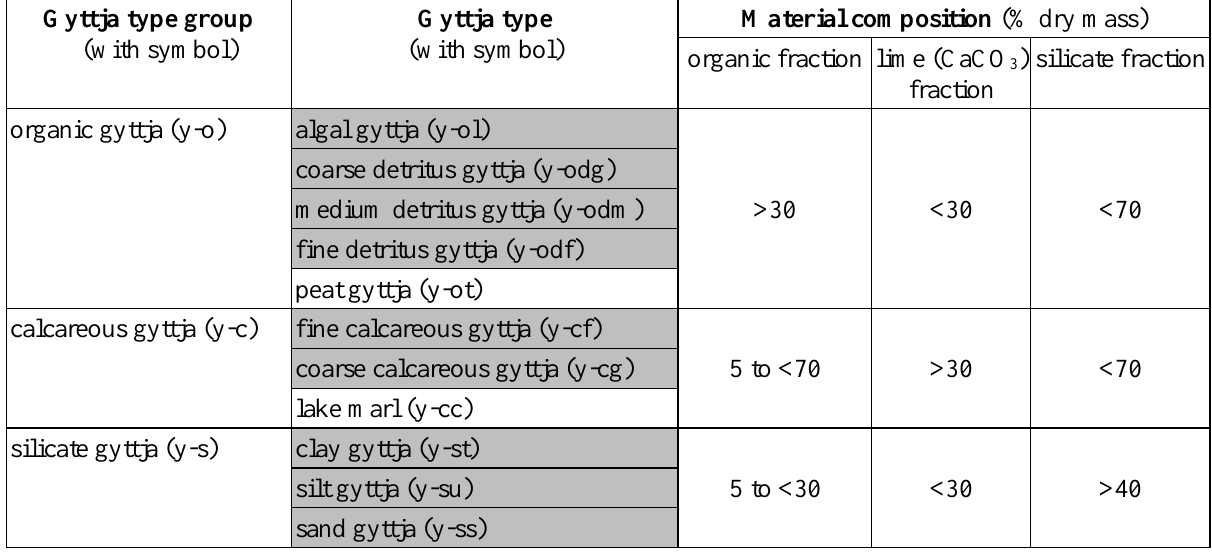
Table A1.5. Gyttja classification of the soil mapping manual of the former German Democratic Republic TGL 24300/04 (1985), translated from German, compared to the gyttja types included in our key and portraits (grey, partly